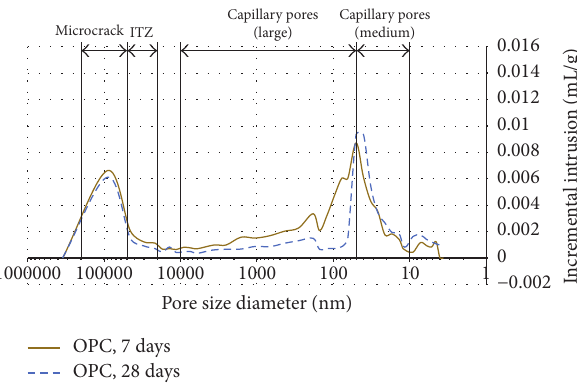
Figure 15: Relationship incremental intrusion and pore size diameter distribution with OPC.